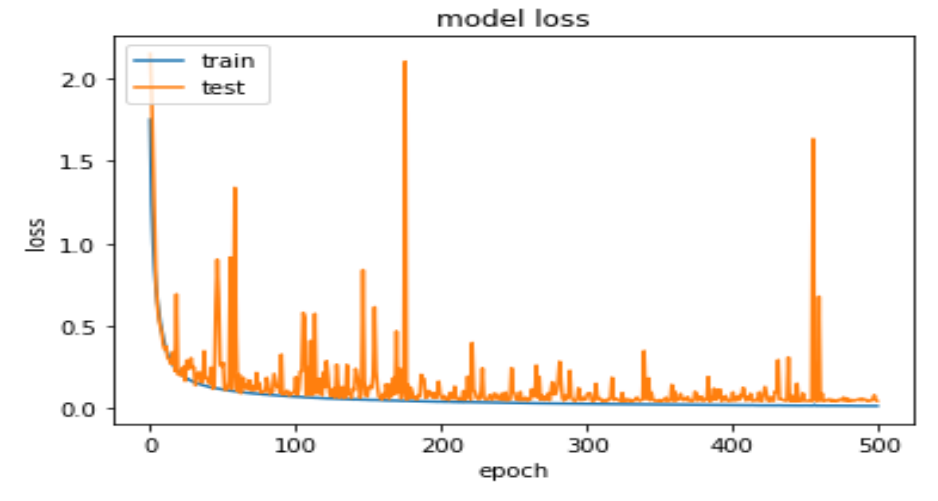
Figure 8. Model loss in training and testing